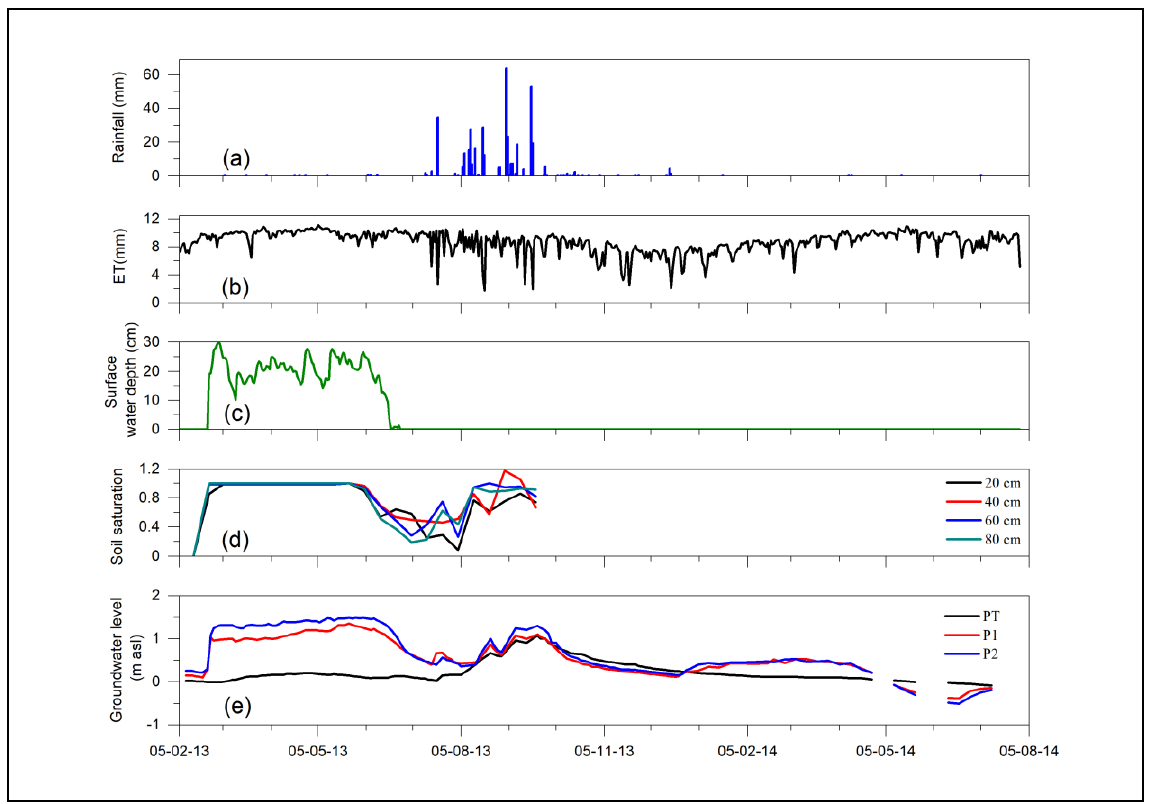
Figure 4. Comparative evolution of the different hydrological parameters: rainfall ( a ), actual evapotranspiration ( b ), the surface water level in the irrigated plot ( c ), soil saturation ( d ) and groundwater levels ( e ).